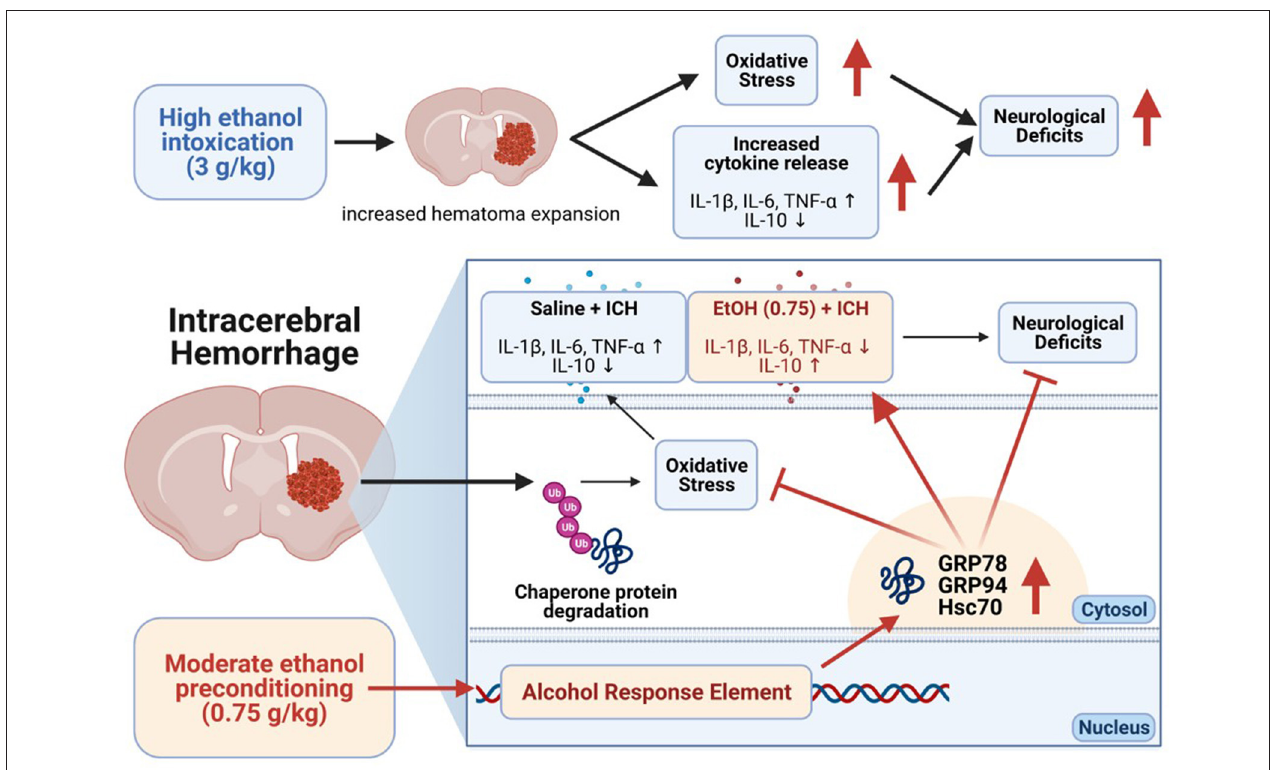
FIGURE 8 | Overview mechanism of the moderate ethanol pre-conditioning in ICH-induced injury.